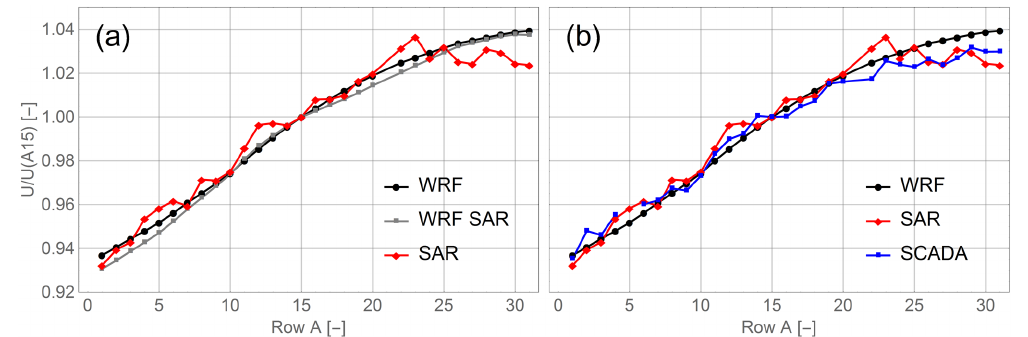
Figure 6. Average wind speed relative to turbine A15 for wind directions between 245 and 275 ◦ . (a) Data from WRF (2002–2012) and SAR (2002–2012). The entire time period is used for “WRF” and WRF data coinciding with SAR images are used in “WRF SAR”. (b) Data from full WRF time series, SAR, and SCADA (2013–2015). No turbine was erected at location A21.